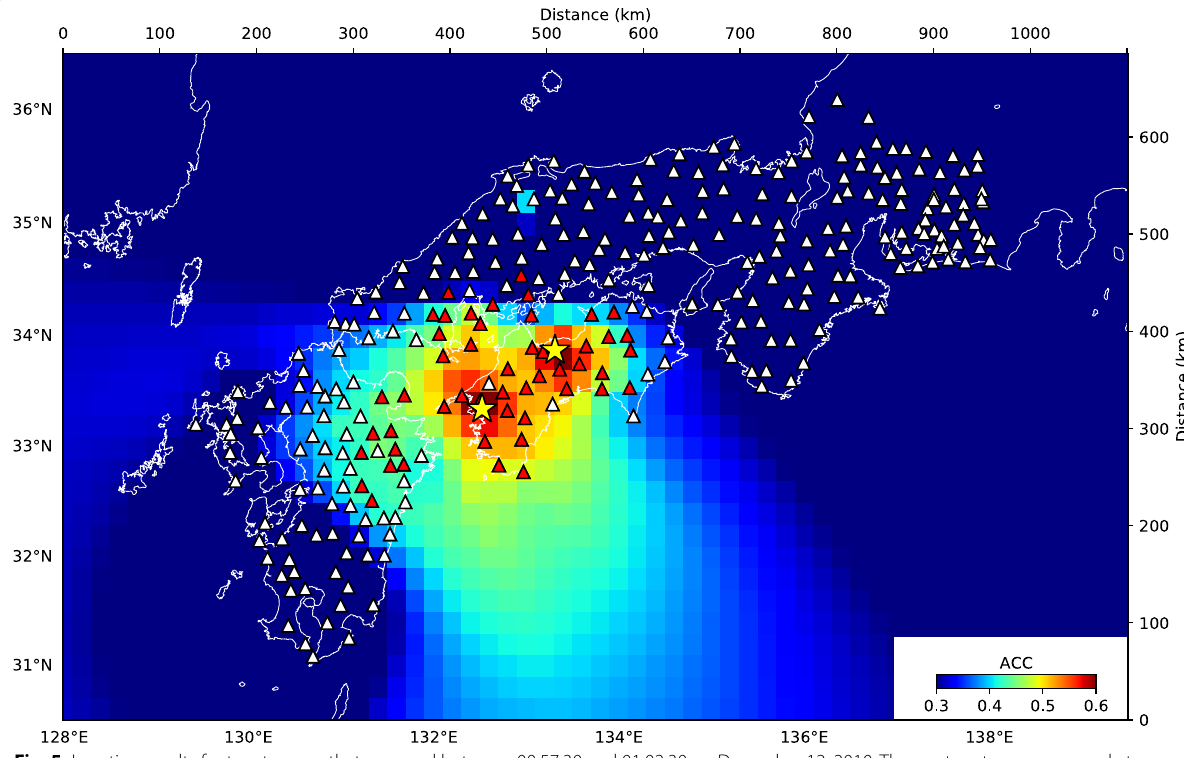
Fig. 5 Location results for two tremors that occurred between 00:57:30 and 01:02:30 on December 12, 2010. The western tremor occurred at 01:02:08, with a hypocentral location of 33.350°N, 132.525°E, and 30.6 km depth. The eastern tremor occurred at 01:02:08, with a hypocentral location of 33.877°N, 133.312°E, and 31.5 km depth. The distance between the two tremor epicenters is ~ 100